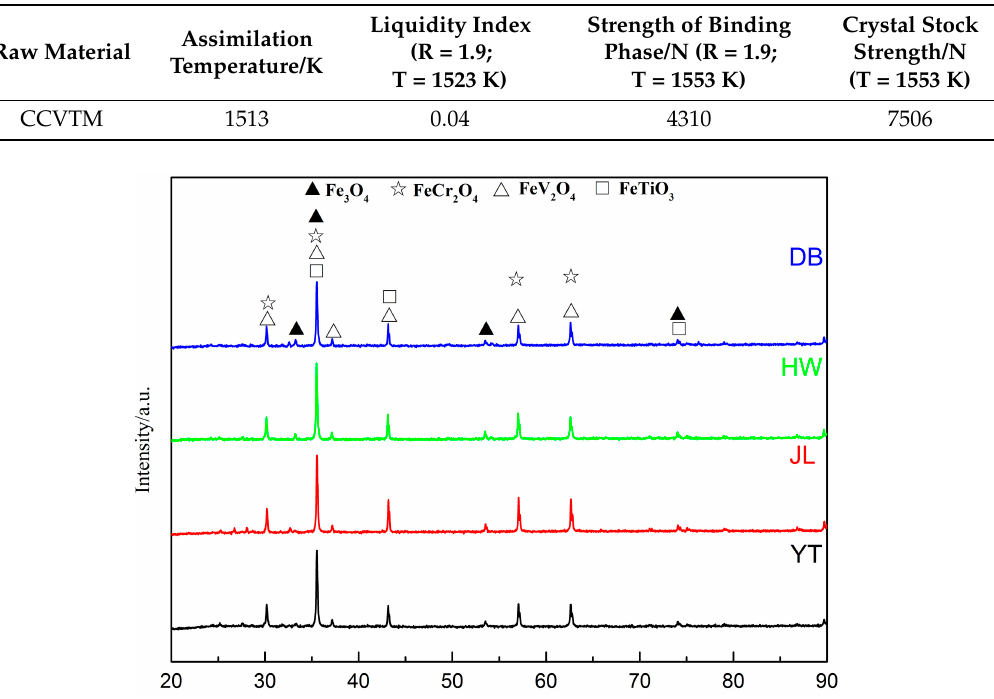
Table 3. The basic characteristics of the Chengde chromium-bearing vanadium–titanium magnetite (CCVTM).